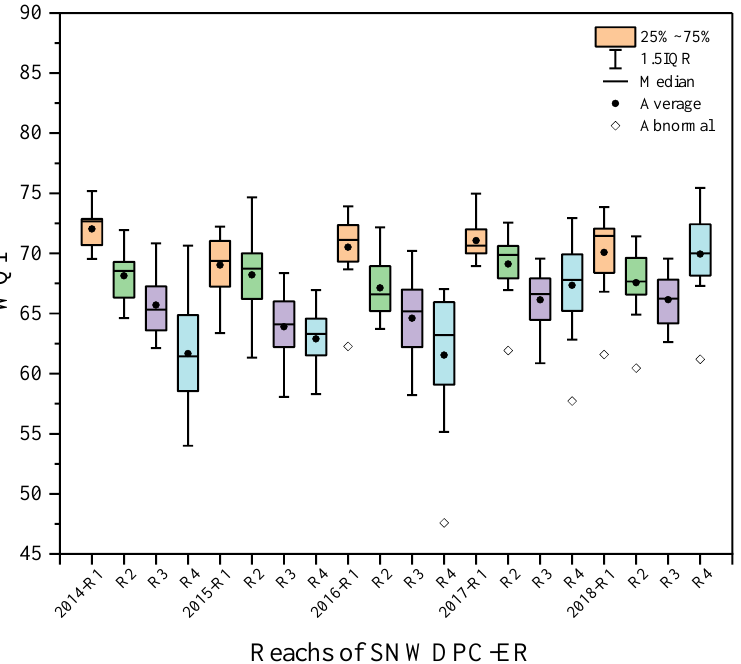
Figure 2. Spatial variations in the WQI in the SNWDPC-ER (from 2014 to 2018; orange: R1, green: R2, purple: R3, blue: R4).